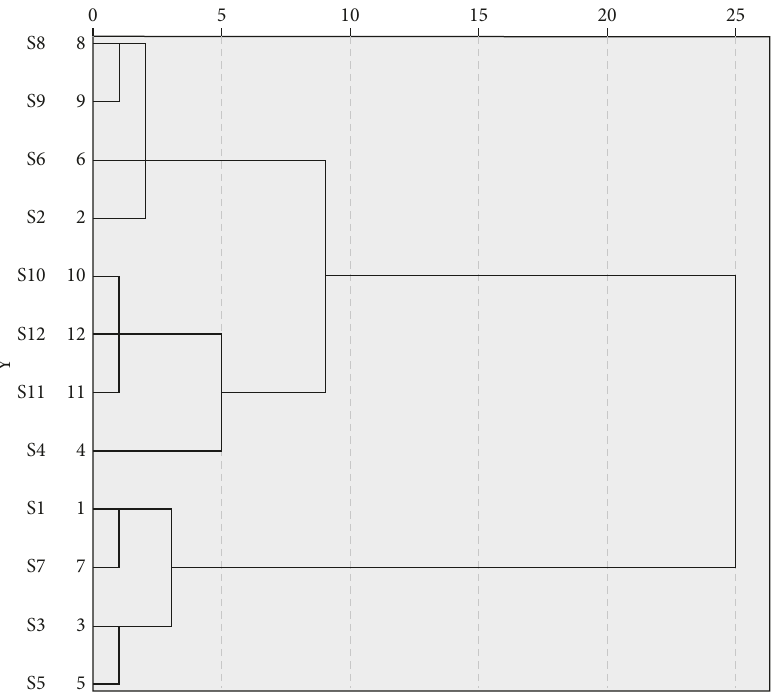
Figure 3: Tree diagram of cluster